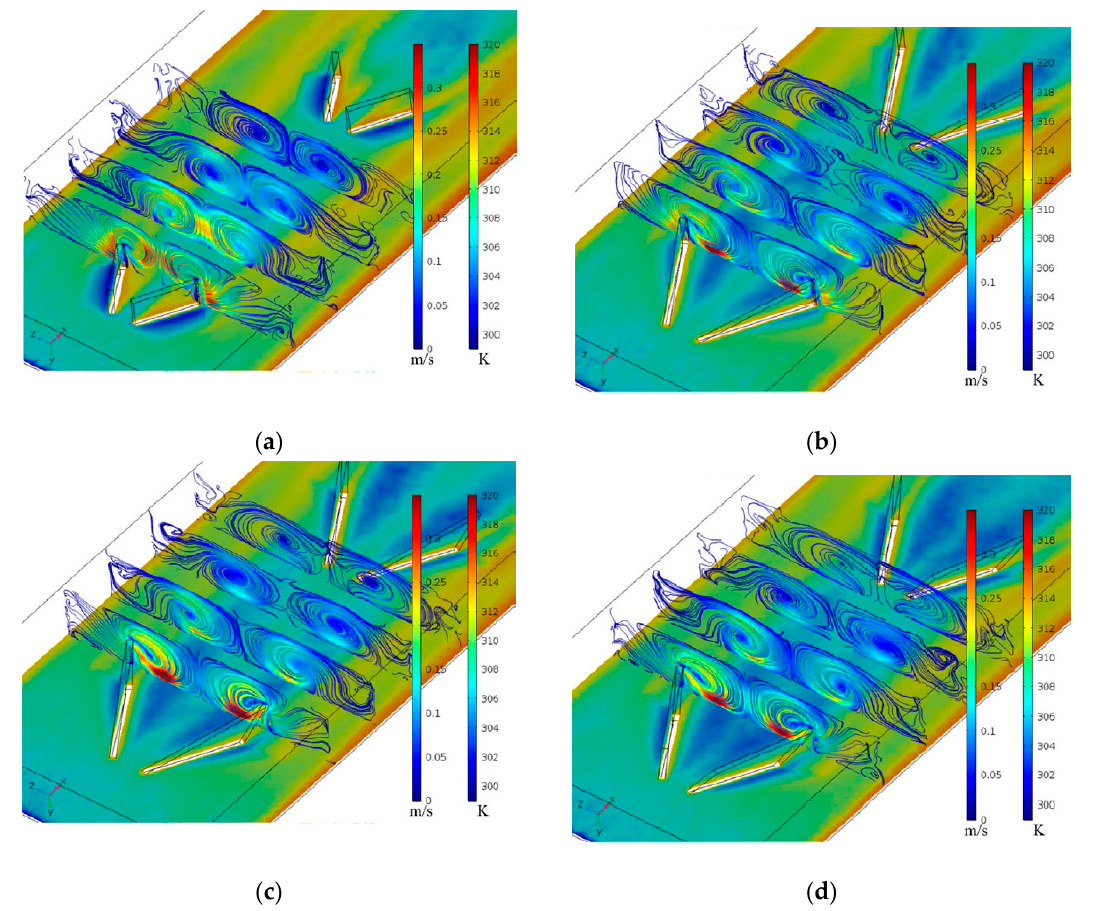
Figure 8. Vortex velocity on several yz planes between the first two rows of VGs and the resulting air temperature distribution on a xz plane that is 0.1 mm above the solid fin surface for the plate-fin with (a) rectangular winglet pair (RWP), (b) delta winglet pair (DWP), (c) swept delta winglet pair (SDWP), and (d) swept trapezoid winglet pair (STWP) at airflow velocity of 5 m/s.